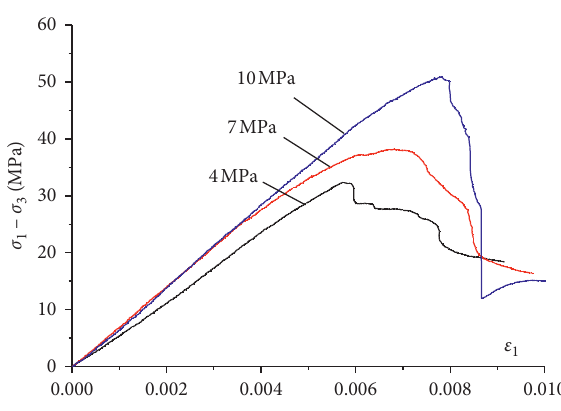
Figure 3: Stress-strain curves from triaxial compression tests under different confining pressure